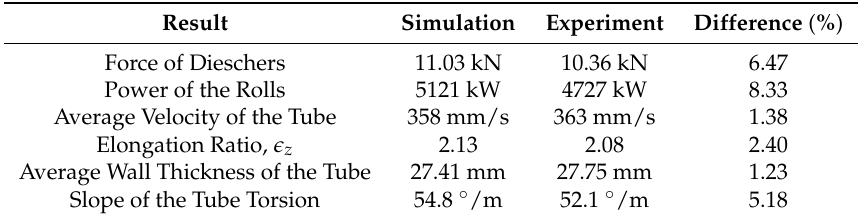
Table 6. Simulation results and their difference to the experimental values.